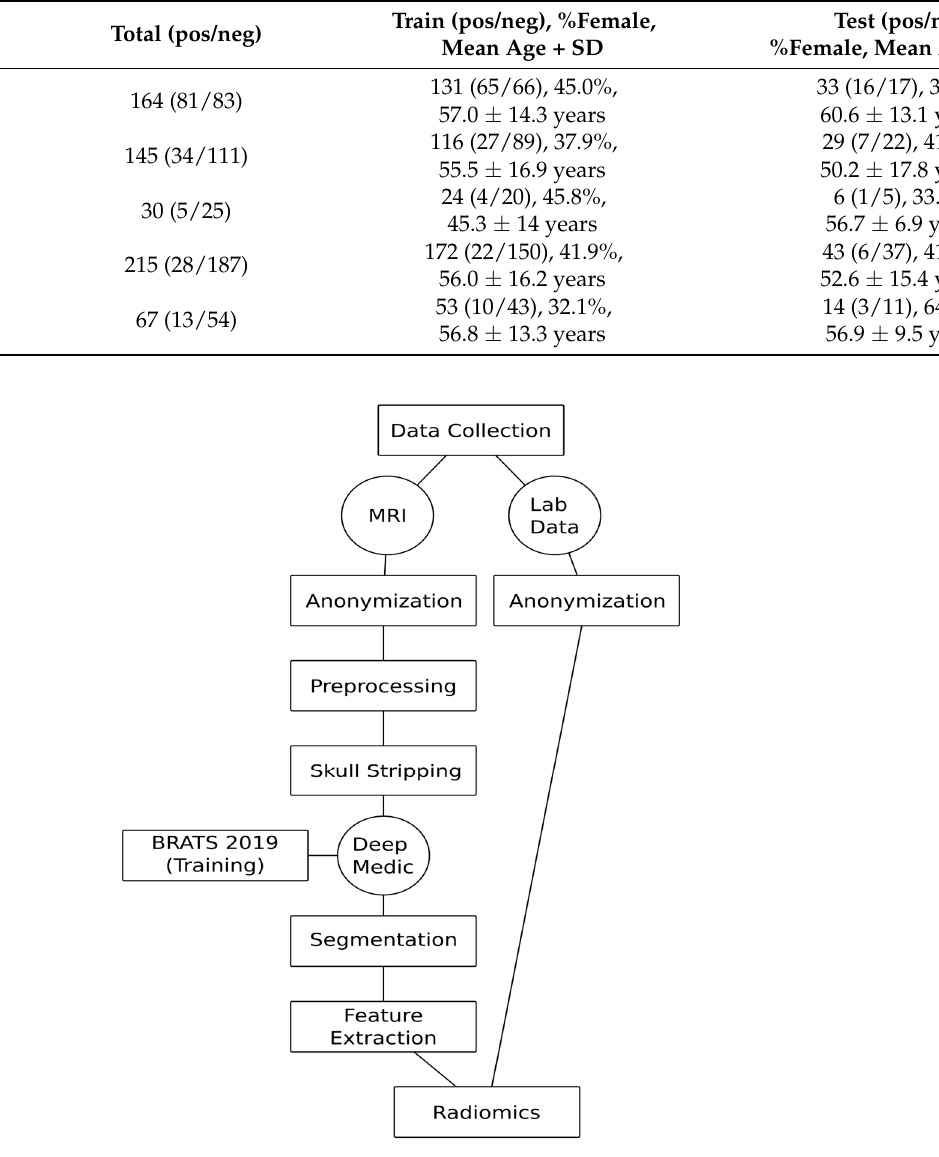
Table 1. Initial patient collective: Distribution of the training, testing and total cohort of the respective genetic parameters, age and gender. A positive label is defined as having an IDH1/2 mutation, an ATRX expression loss, a 1p19q co-deletion and a positive MGMT methylation status. For the WHO label, LGG is defined as positive and HGG as negative. The gender distribution is expressed as the percentage of females in the collective.